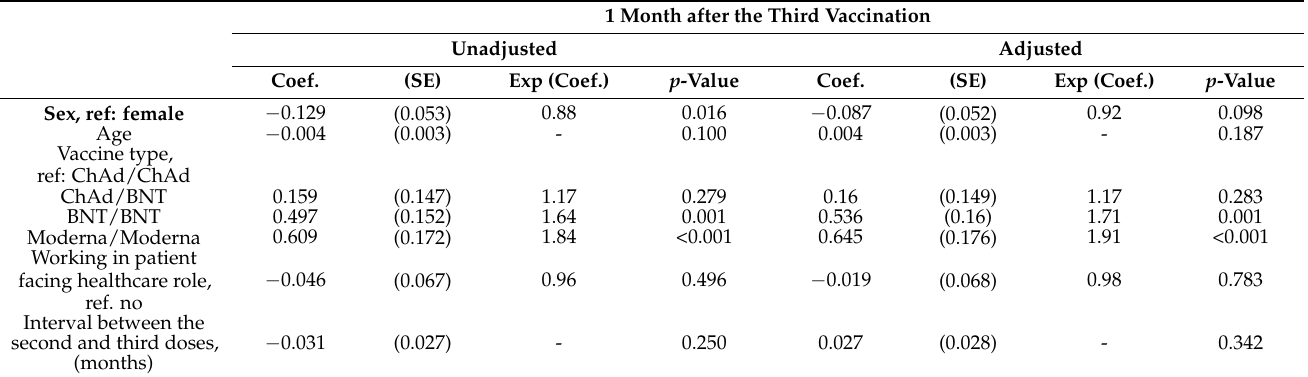
Table 2. Factors associated with anti-SARS-CoV-2 S-RBD IgG levels 1 month after the third